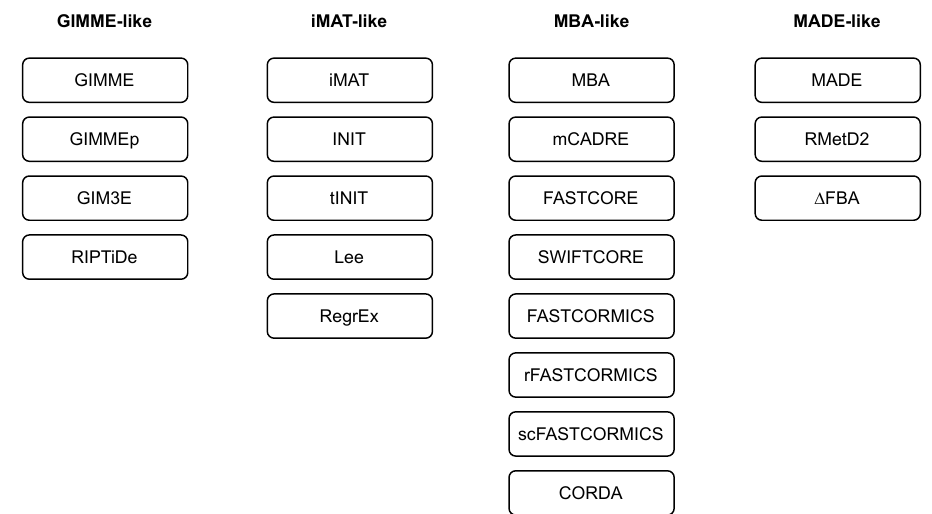
Figure 2. Families of algorithms for automated reconstruction of context-specific